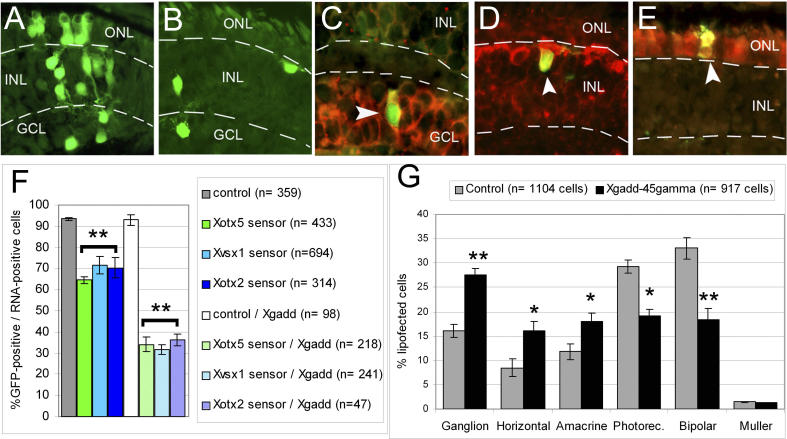
Cell Cycle Inhibiton by Xgadd-45γ Lipofection Affects Translation and Cell Fate(A–E) Retinal sections (st. 42) of control-lipofected retinas (A) or Xgadd-45γ–lipofected retinas (B–E). Xgadd-45γ lipofection decreases the size of lipofected cell clusters. (C–E) Show lipofected cells (GFP-traced) counterstained (arrowheads) with cell type markers: (C) ganglion cells (Fast Red mRNA detection of hermes), (D) horizontal cells (Fast Red mRNA detection of prox1), (E) cones (calbindin red immunodetection). ONL: outer nuclear layer; INL: inner nuclear layer; GCL: ganglion cell layer.(F and G) Bars indicate the proportions of lipofected cells translating sensors (F). Bars showing the proportions of lipofected cell types at st. 42 are indicated by (G). Number of counted cells is indicated by n; single asterisk indicates p ≤ 0.05; double asterisk indicates p ≤ 0.01 (student's t-test); error bars: standard error of the mean.